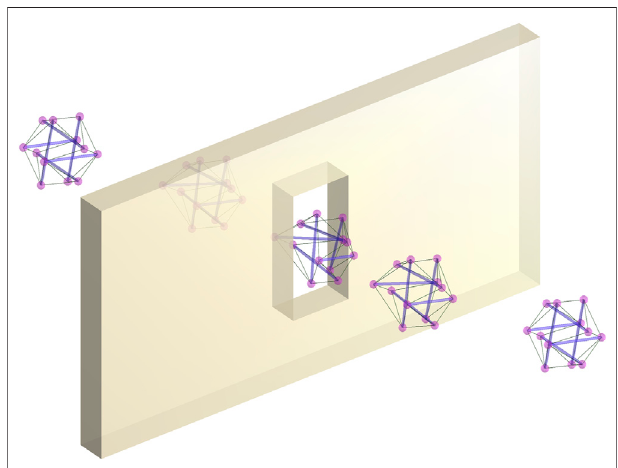
Frontiers in Robotics and AI |